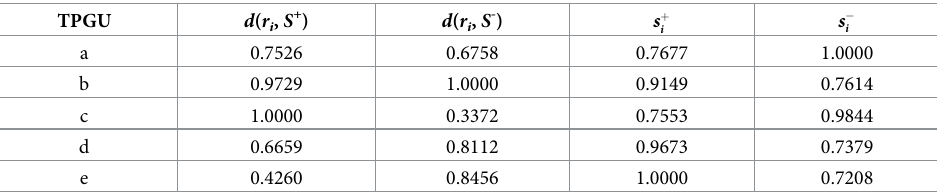
Table 6. Dimensionless